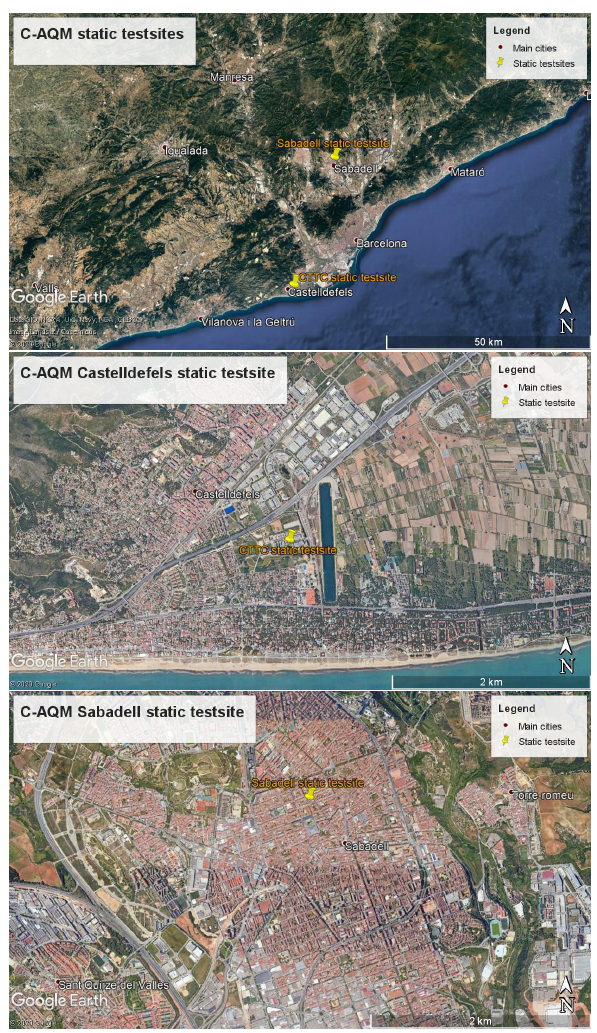
Figure 2. Location of static test-sites. Top.- Location within a Figure 3. Location of dynamic test-sites. Top.- Castelldefels global map; Middle.- Castelldefels test-site; Bottom.- Sabadell test-site; Middle.- Sabadell test-site; Bottom.- Castelldefels - test-site. Viladecans test-site.